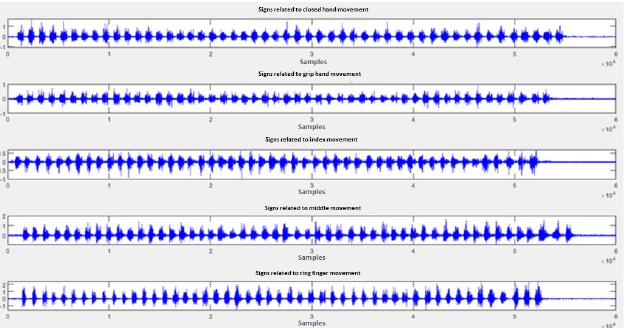
Figure 14. Samples sequences related to each hand movement to be characterized, obtained from the sensor and plotted by